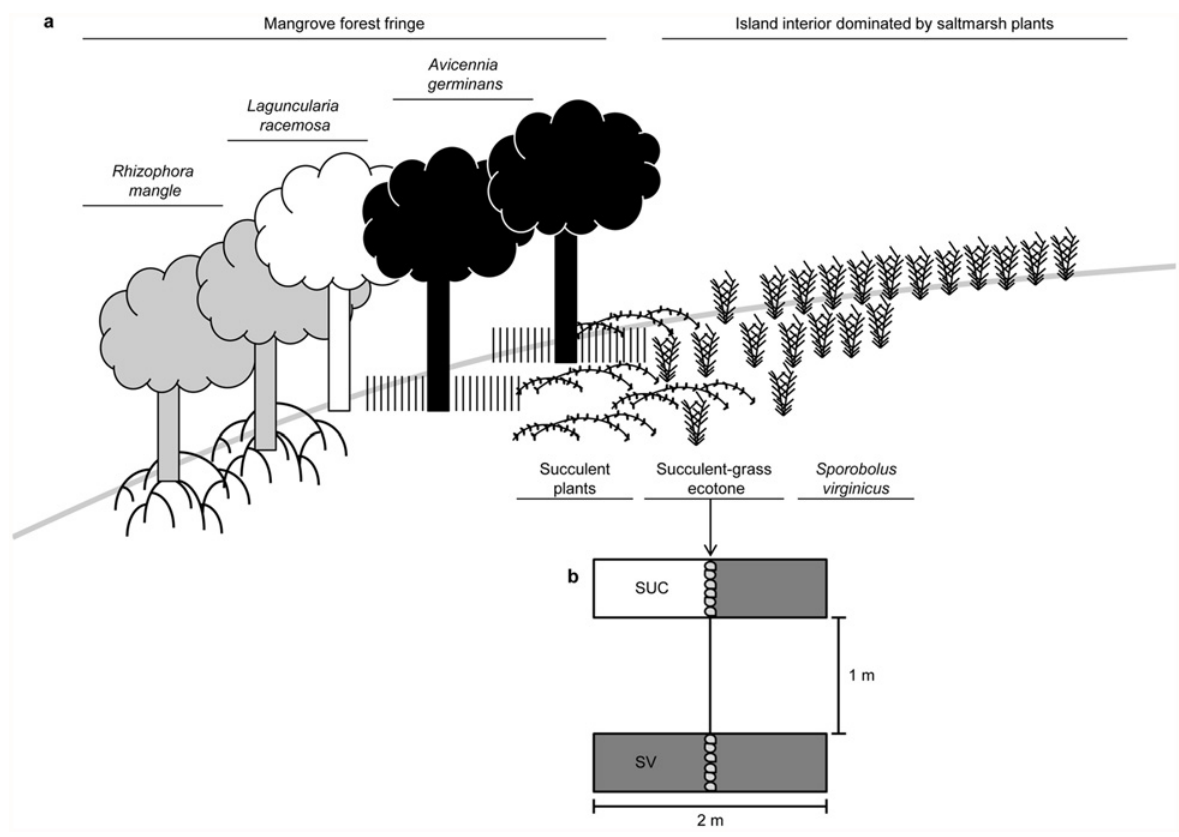
Fig 1. Study site diagram and experimental design. a) Schematic diagram (not to scale) of main plant taxa along tidal gradient at study site on Cannon Island. b) Design of experimental plots at succulent-grass ecotone with initial position of propagules; shading indicates saltmarsh composition: ( S . virginicus = gray; succulent plants = white) for saltmarsh grass monoculture (SV) and succulent-grass ecotone (SUC) treatments.